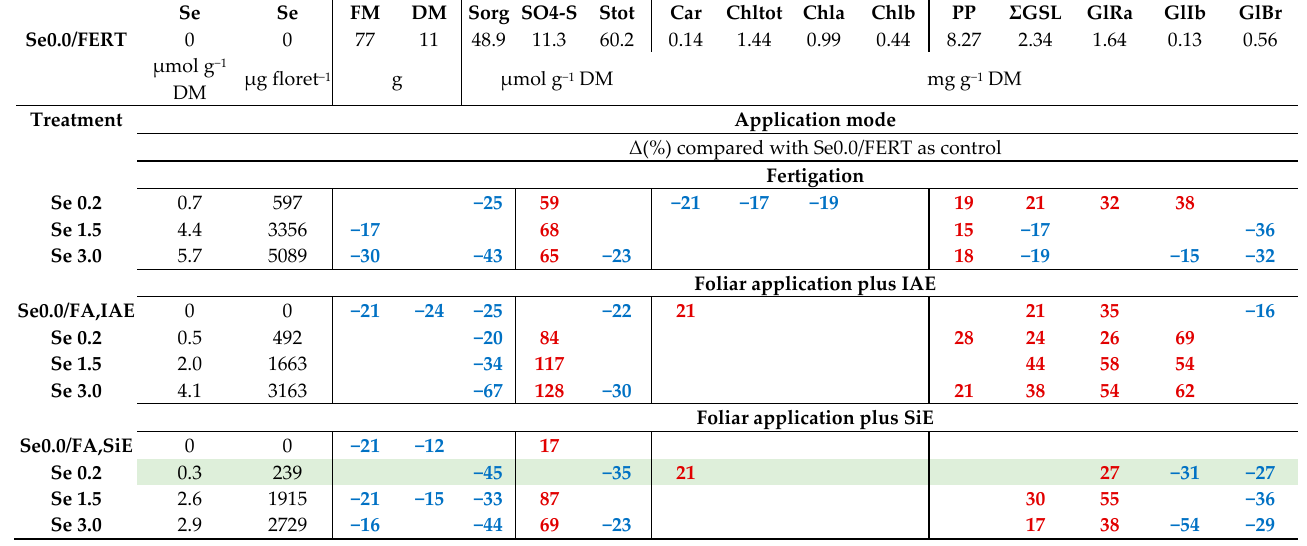
Table 4. Overview of the performance of the application mode per treatment for the applied Se concentrations, in terms of percentage difference with the control plants (Se0.0/FERT). The percentage of changes was evaluated against the selenium content of florets either as µ mol g − 1 DM or µ g floret − 1